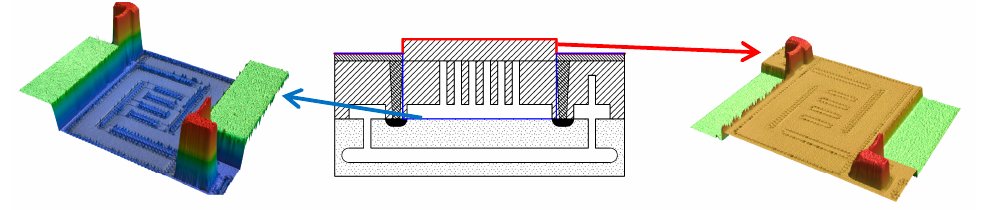
Figure 3. 3D scan over the filament ( left ) and lid surface ( right ) made by means if lase microscopy.